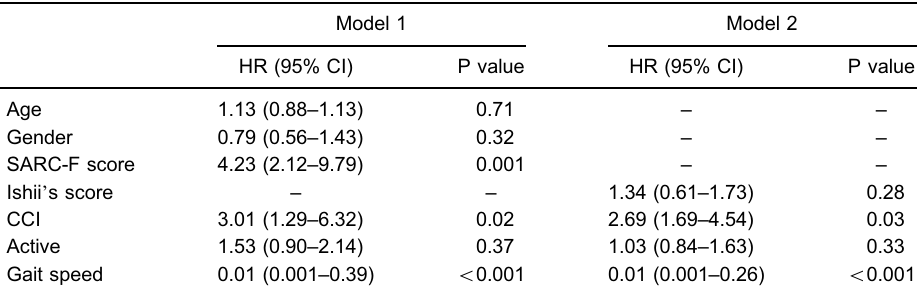
Table 3. Results of multivariate Cox proportional hazard analysis for